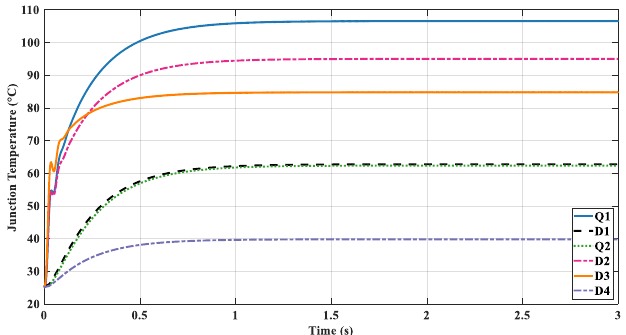
Figure 15. The junction temperature of the power semiconductors within the Cuk converter.